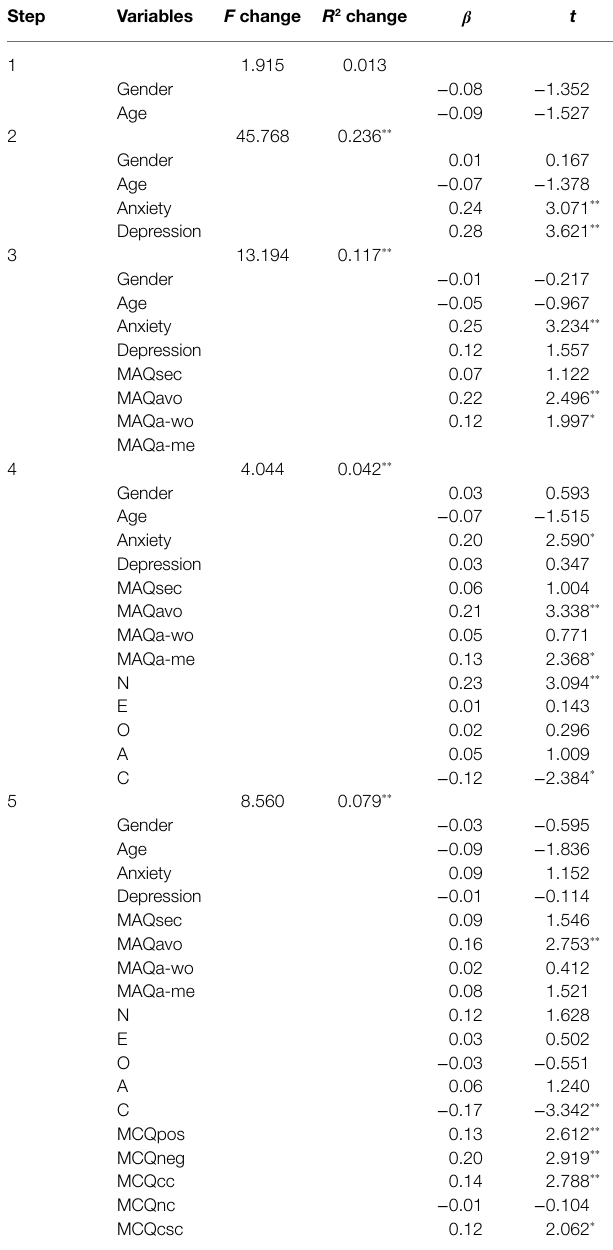
TABLE 2 | Hierarchical linear regression with interpersonal problems as the dependent, and gender, age, attachment, personality, and metacognitions as predictors ( N =